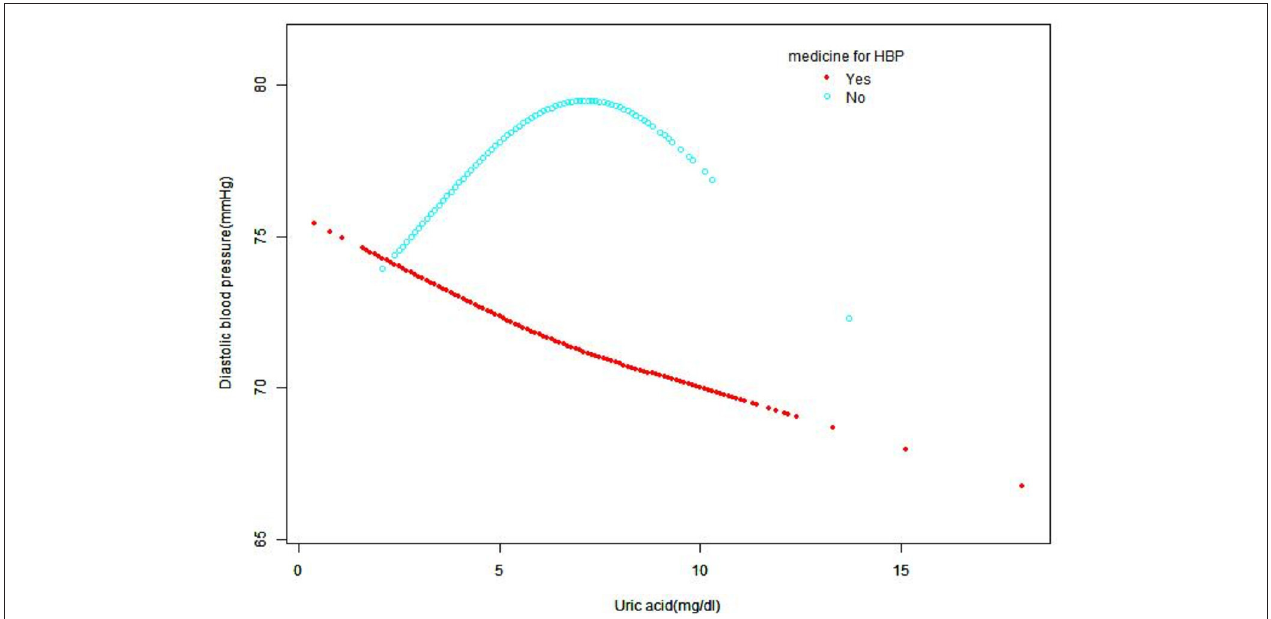
FIGURE 3 | Smooth curve fitting for the relationship between UA and DBP in hypertension treatment group and non-treatment group, adjusted for gender, age, race, creatinine, glucose, hemoglobin, HDL, TC, GFR, LDL, alcohol consumption, diabetes, smoking, and BMI. HDL, high-density lipoprotein; TC, total cholesterol; GFR, Glomerular filtration rate; DBP, diastolic blood pressure; UA, uric acid; LDL, low-density lipoprotein; BMI, body mass index; HBP, high blood pressure.